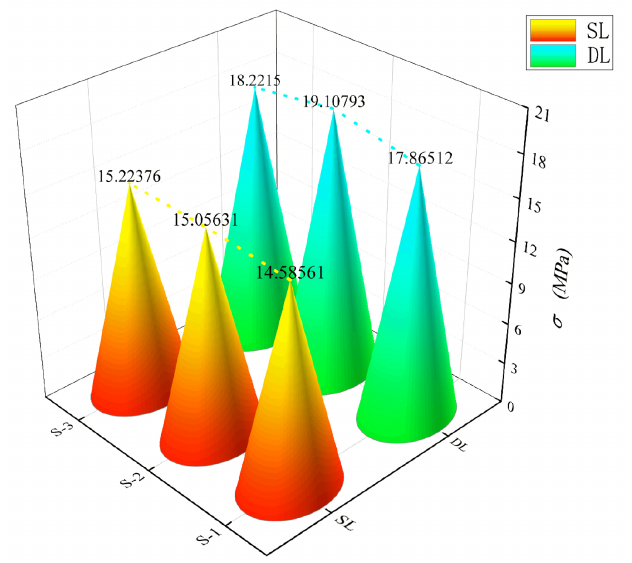
Figure 6. Ultimate bending stress of BTRC sheet using different laying